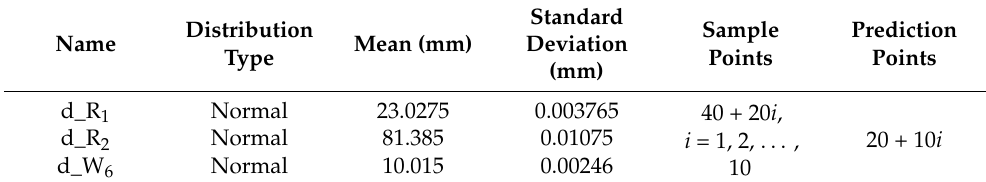
Figure 11. Variable geometric parameter of the GH720Li turbine disk, where the three key parameters are marked with blue circles. Table 5. The distribution and sampling scheme for 3 random variables.